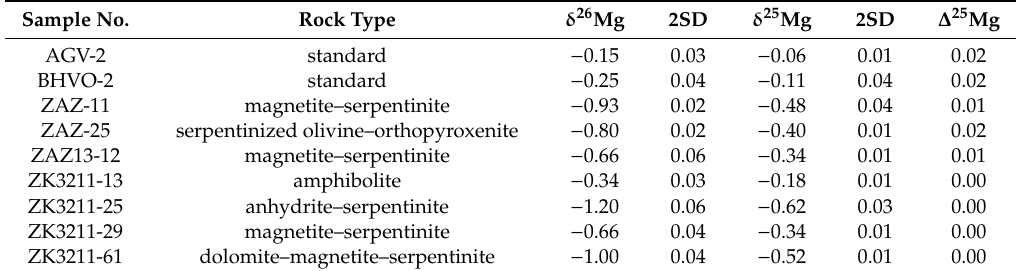
Table2. Mgisotopiccompositions(% (cid:24) )ofreferencematerialsandrepresentativemagnesiumsilicate-rich rocks from the Zhaoanzhuang iron